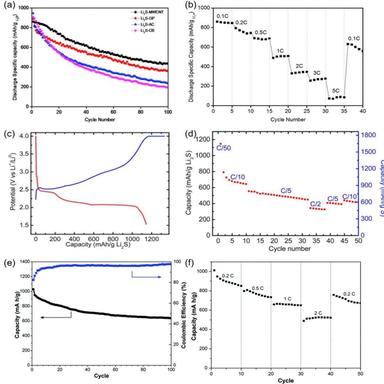
(a) Cycling performance and (b) rate capability of Li2S-MWCNTs by Kaiser et al. (1.5 mg Li2 S=cm2 at 0.1C). (c) Voltage profiles in the first cycle at C/50 and (d) cycling performance of Li2S-CB with 67.5 wt% Li2S by Cai et al.. (e) Cycling performance and CE (at 0.2C) and (f) the rate capability of the Li2S@HC batteries with 72 wt% Li2S by Chen et al. . Reproduced from Refs. with permission from Elsevier, the American Chemical Society and Royal Societ